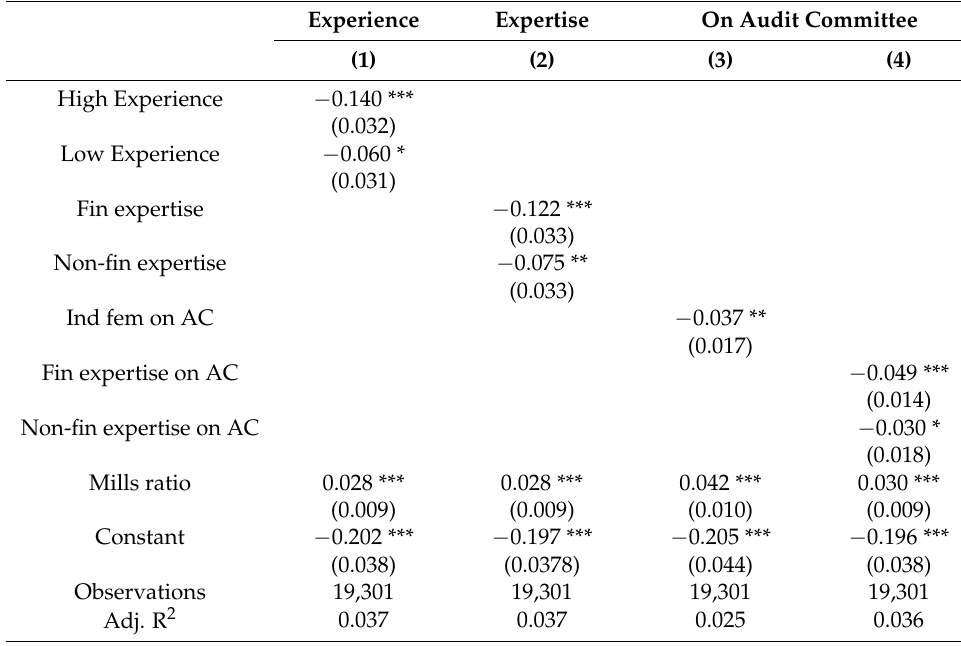
Table 10. Cont. Panel (B) Characteristics of Independent Female